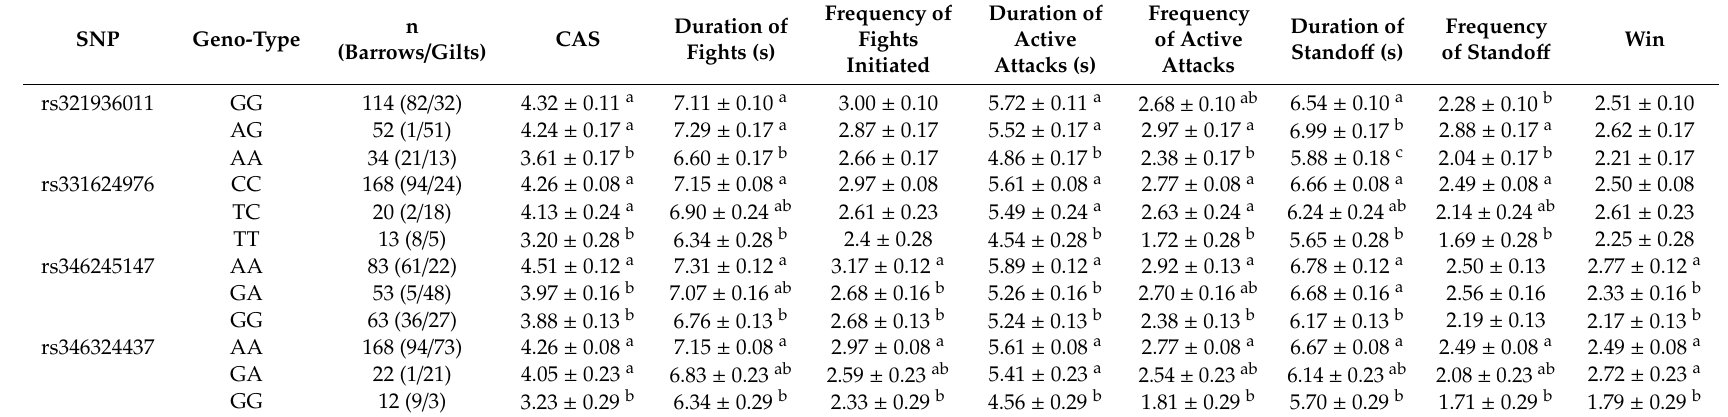
Table 3. Aggressive behavior indicators of pigs with di ff erent genotypes of the four linked